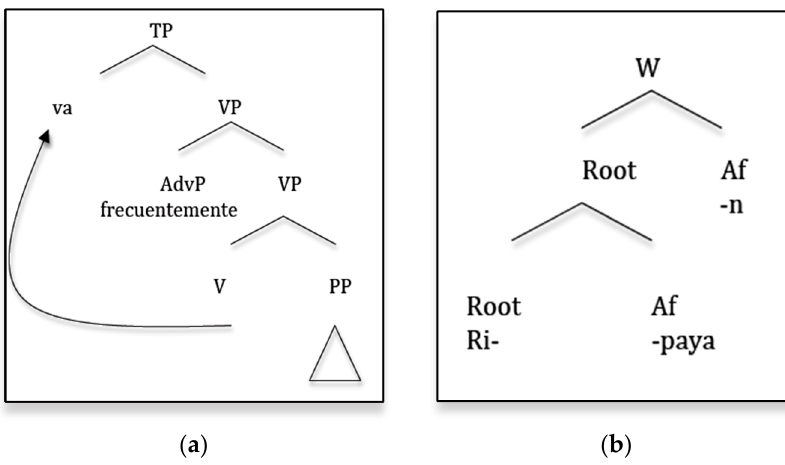
Figure 1. ( a ) Independent words in the Spanish syntactic structure; ( b ) suffixes at the Quechua word-level configuration.